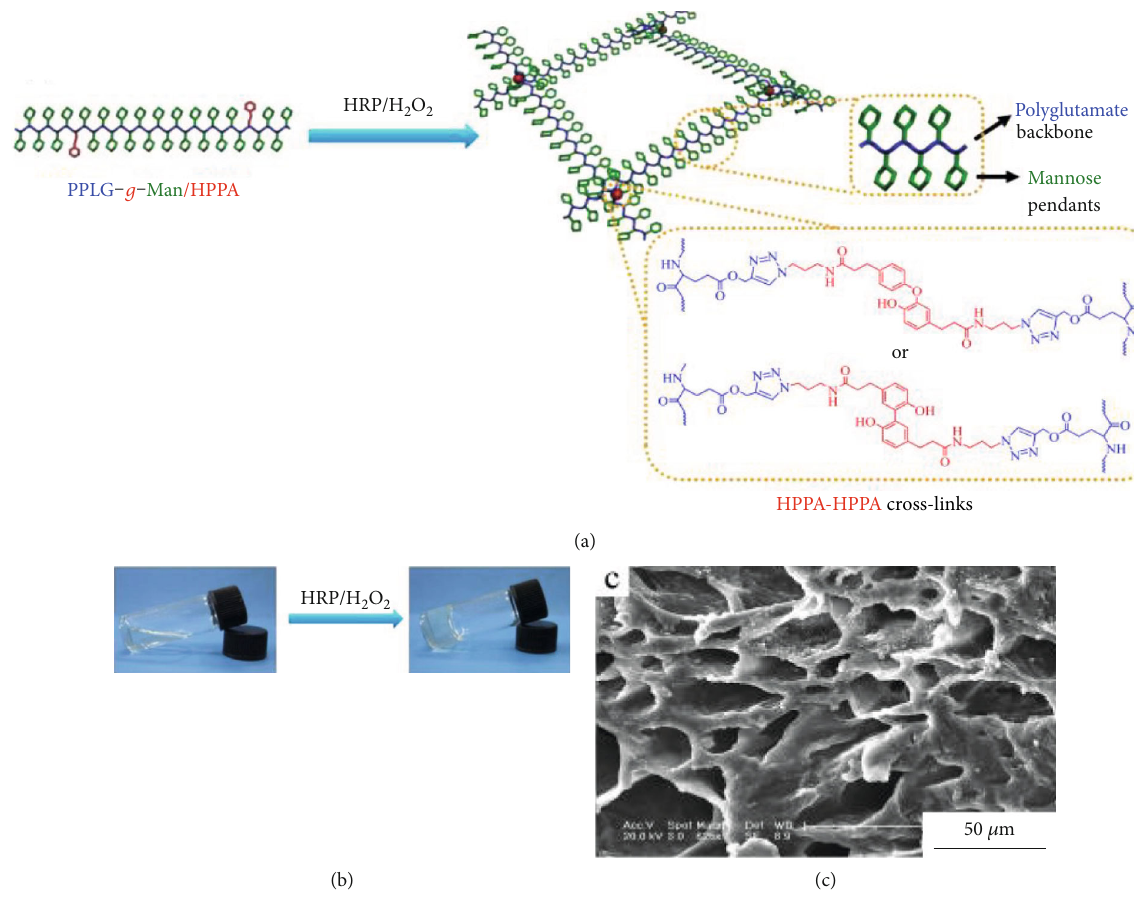
Figure 9: (a) Schematic illustration for the formation of crosslinking networks of PPLG- g -Man/HPPA hydrogels; (b) photographs of PPLG- g -Man/HPPA precursor solution and the hydrogel (6% ( w / v )) formed with 1.0 unit/mL of HRP and 2.4mM of H lyophilized PPLG- g -Man/HPPA hydrogels crosslinked with 1.0 unit/mL of HRP and 1.6mM of H (reprinted with permission from Ref. [94]; copyright (2013) American Chemical Society).